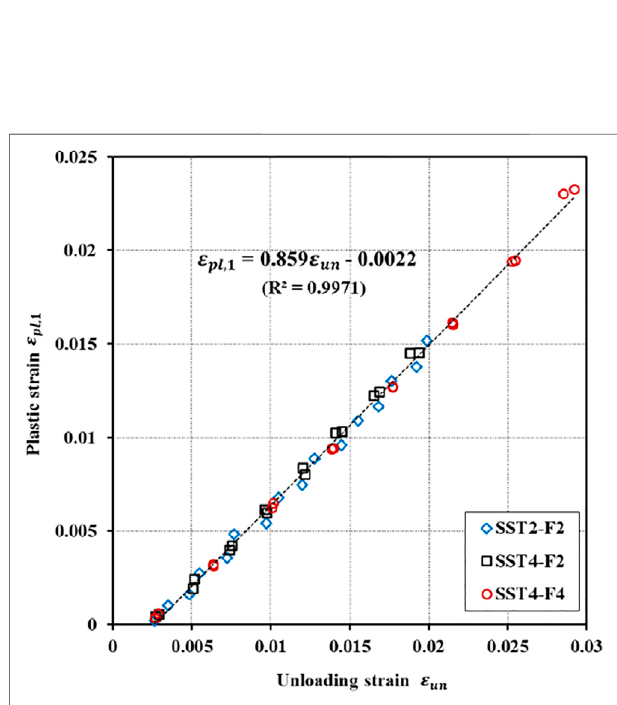
FIGURE 10 | Relationship between ε pl , 1 and ε un in this